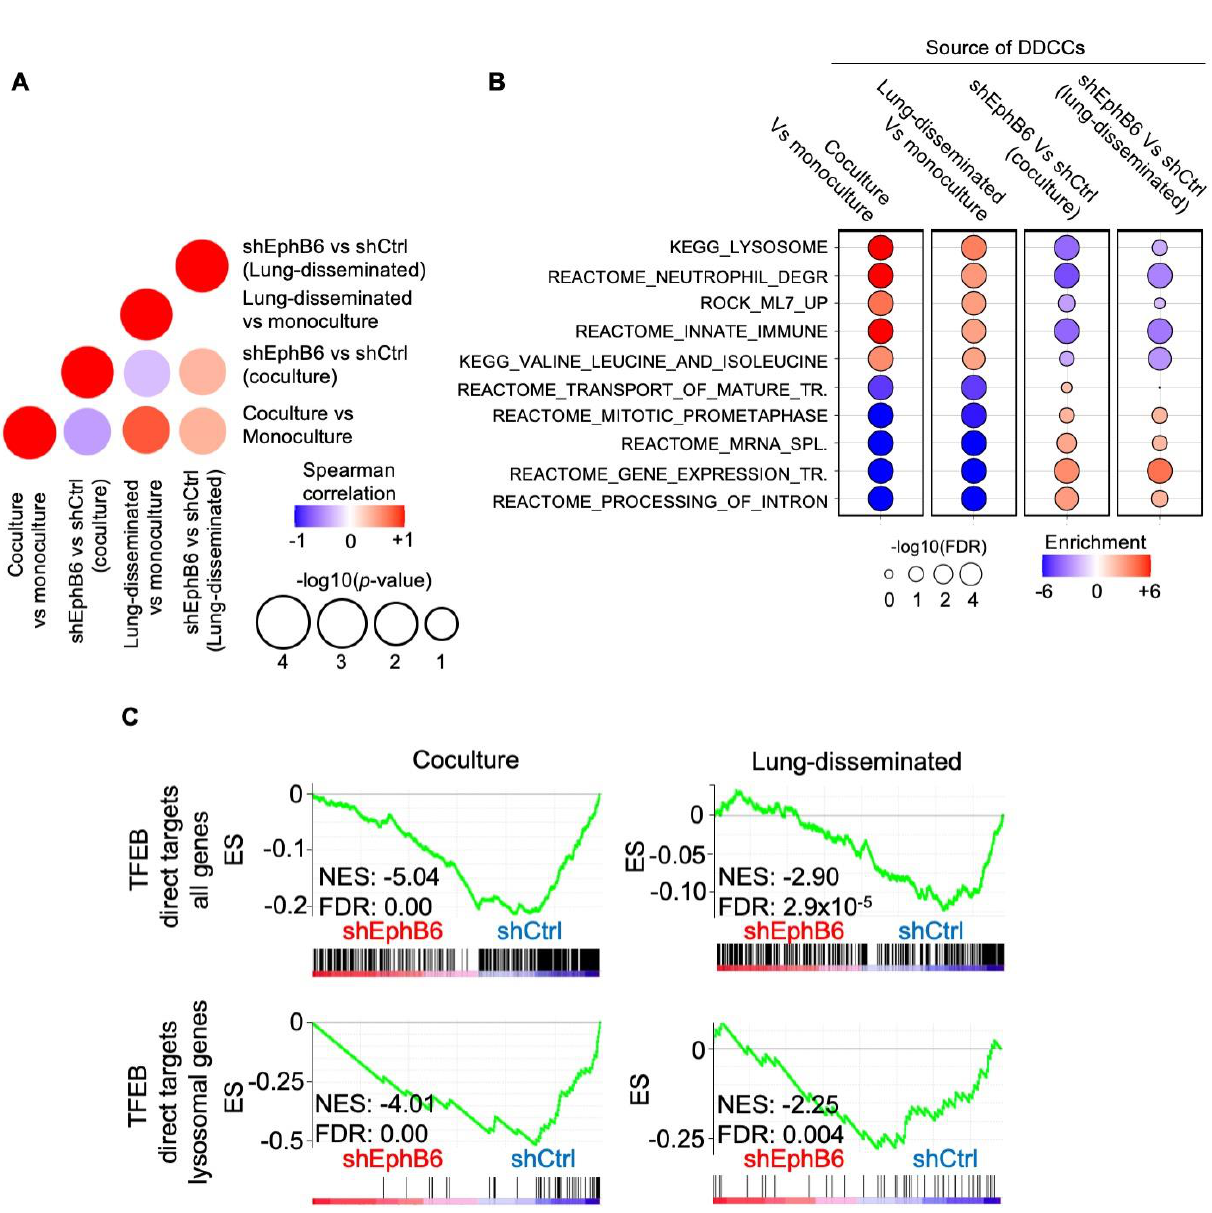
Figure 4. Transcriptomic analysis of DDCCs depleted cells in vivo and in coculture. ( A ) Dot plot shows the correlation of NES values generated from GSEA between four indicated comparisons, where the color represents the Spearman correlation and size presents the –log 10 ( p -value) of the correlation. ( B ) Balloon plot summarizing GSEA results of the indicated comparisons for each indicated gene sets. The plot was manually curated to help visualize and show gene sets with higher coherent enrichment in the different conditions. Balloon size represents the statistical significance (-log 10 FDR), while color indicates the fold-enrichment for each term. Complete list of gene sets in Figure S2. ( C ) Profile of the running ES score for gene sets including TFEB direct lysosomal targets after GSEA of D2.0R-EGFP cells with shCtrl or shEphB6 either disseminated in vivo or in coculture with AT1-like cells.